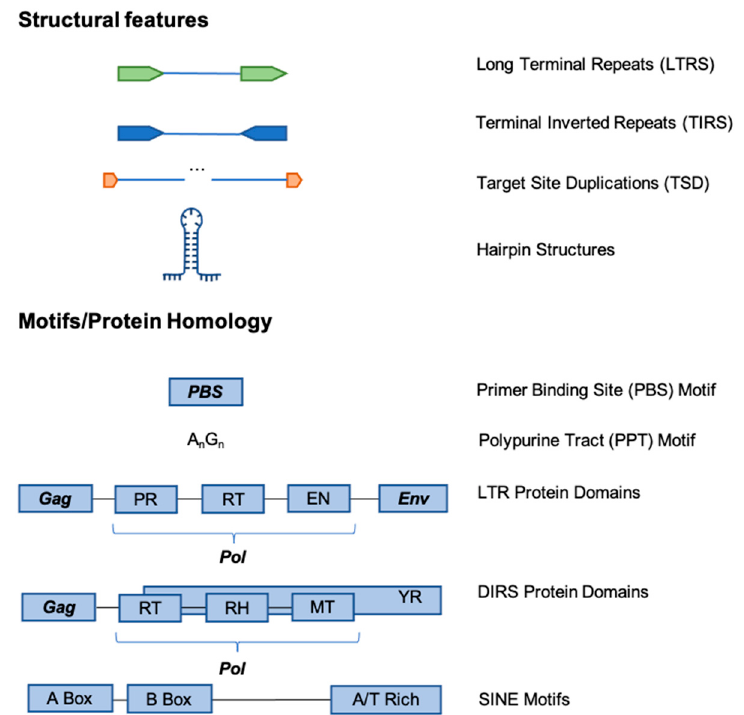
Figure 5. Examples of commonly used TE Signatures for Detection. Structural features: the identification of LTR/ERV elements, class II elements, non-LTR retrotransposable elements, and Helitrons can be achieved by searching for LTRs (~100–1000 bp direct repeats), TIRs (~10–40 bp inverted repeats), TSDs (6–21 bp on average duplications), and hairpin structures, respectively. In addition, the A and B boxes seen in RNA polymerase III promoters and 3 ′ terminal A/T-rich sequence can be used to identify SINE elements. Motifs/Protein Homology: the order, orientation, and similarity to protein domains is key to homology-based searches. Gag: group-specific antigen; PR: pathogenesis-related; RT: reverse transcriptase; EN: endonuclease; Env: envelope; RH: ribonuclease H; MT: methyltransferase; YR: tyrosine recombinase. Other sequence structures (not seen in the figure above) observed in LINEs are their poly-A or simple-repeat tails, and the RT and apurinic–apyrimidinic EN (APE) domains of the Pol protein.